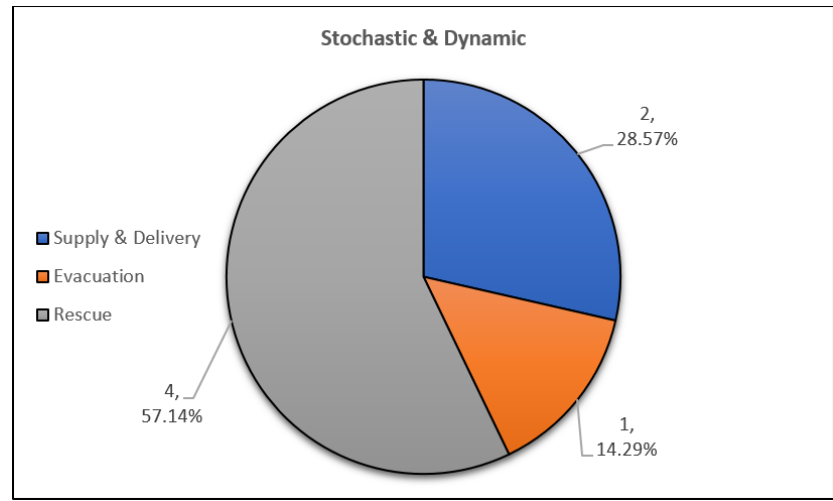
Figure 18. Selected Humanitarian Operation based on Split Delivery VRP (SDVRP).